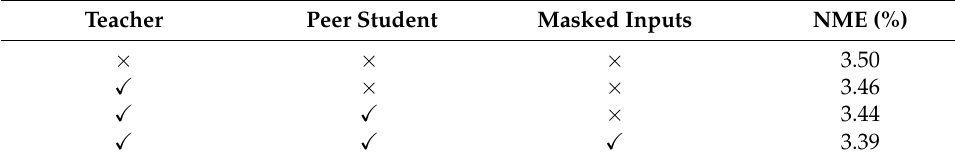
Table 6. NME (%) of our method using different KD components on the 300W full